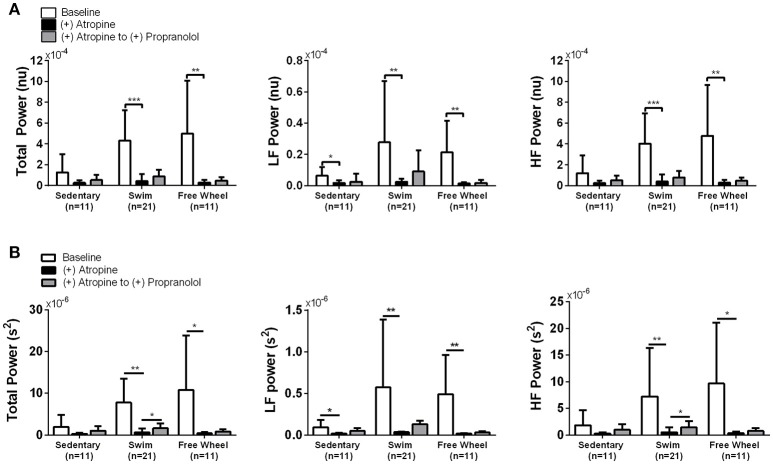
Effects of cardiac autonomic blockade on HRV. (A) HR corrected total, LF, and HF power of the HRV in the absence of cardiac autonomic blockade (Baseline), after atropine, and after atropine plus propranolol. Total, LF, and HF power of the HRV were higher in exercised mice compared to sedentary mice. Atropine treatment reduced total (P < 0.006), LF (P < 0.008), and HF (P < 0.006) power of the HRV in exercised mice. Atropine also reduced LF HRV (P = 0.011) with evidence of reductions in TP (P = 0.075) and HF (P = 0.081) HRV in sedentary mice that did not reach significance. Following propranolol administration in the presence of atropine, there was a mean increase (P = 0.051) in TP and HF HRV for swim exercised mice. (B) The same data as in (A) but in the absence of HR corrected HRV. The differences in TP, LF, and HF HRV identified between the groups of mice are unchanged without HR correction, suggesting HR has a minimal effect on HRV in the current study. Data are presented as mean ± SD. *P < 0.05; **P < 0.01; ***P < 0.001.